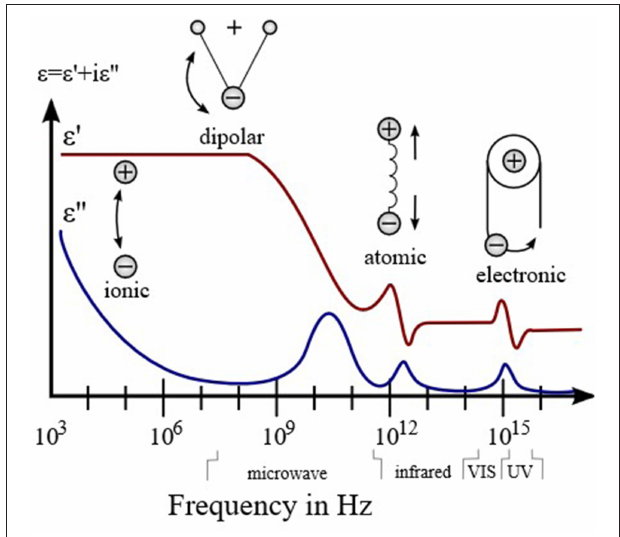
FIGURE 1 | Dielectric permittivity spectrum over a wide range of frequencies. Various processes are labeled in the image.